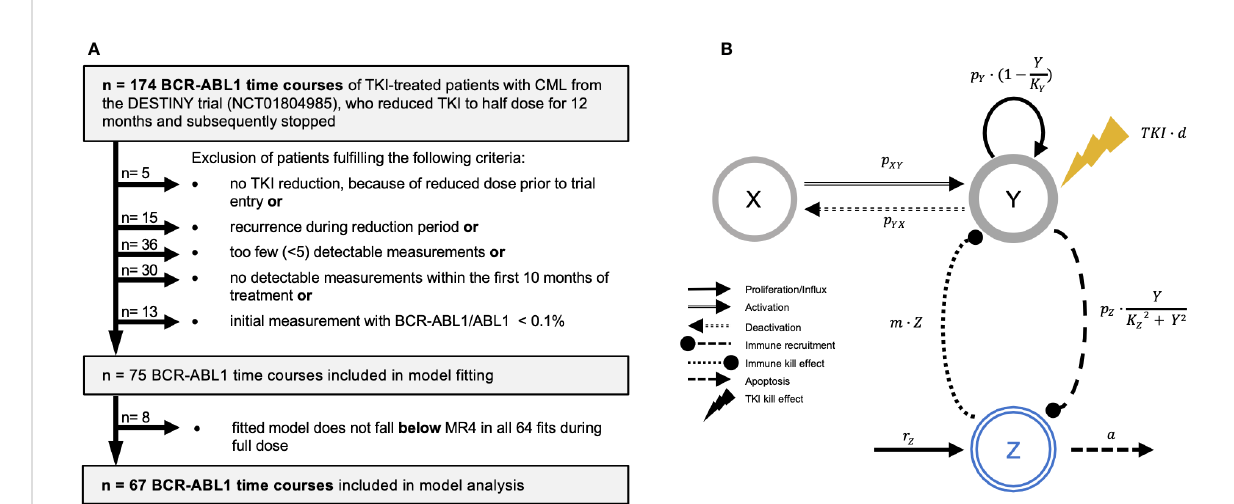
FIGURE 1 (A) Flow diagram indicating the strategy for patient selection. Patients were excluded when they did not undergo TKI reduction, as they entered the trial with a reduced dose already. Additionally, we excluded patients with less than 5 detectable BCR-ABL1 measurements, no detectable measurements, or an initial BCR-ABL1/ABL1-ratio below 0.1%. Furthermore, we excluded patients that presented with a recurrence during reduction period. After model fi tting, we identi fi ed and excluded 8 patients, for which not all of the 64 simulation fi ts did predict BCR-ABL1 levels below MR4 during the full dose treatment period. (B) General scheme of the ODE model setup indicating the relevant cell populations and their mutual interactions (arrows with rate constants) that govern their dynamical responses. Leukemic cells can reversibly switch between ). The the quiescent ( X) and proliferating ( Y) state with corresponding transition rates p XY and p YX . Proliferating cells divide with rate p y · (1 − Y K Y TKI treatment has a cytotoxic effect TKI on proliferating cells (yellow lightning symbol, linearly depending on the dose d ) while quiescent cells are not affected. Immune cells in Z have a cytotoxic effect (with rate m ) on proliferating leukemic cells in Y . The proliferation of immune cells is . This nonlinear term describes an immune stimulated in the presence of proliferating leukemic cells by an immune recruitment rate p Z · Y K 2 + Y 2 window, where the immune response is suppressed for high leukemic cell levels above the constant K Z . Moreover, immune cells are generated by a constant production r z and undergo apoptosis with rate a (see Materials and